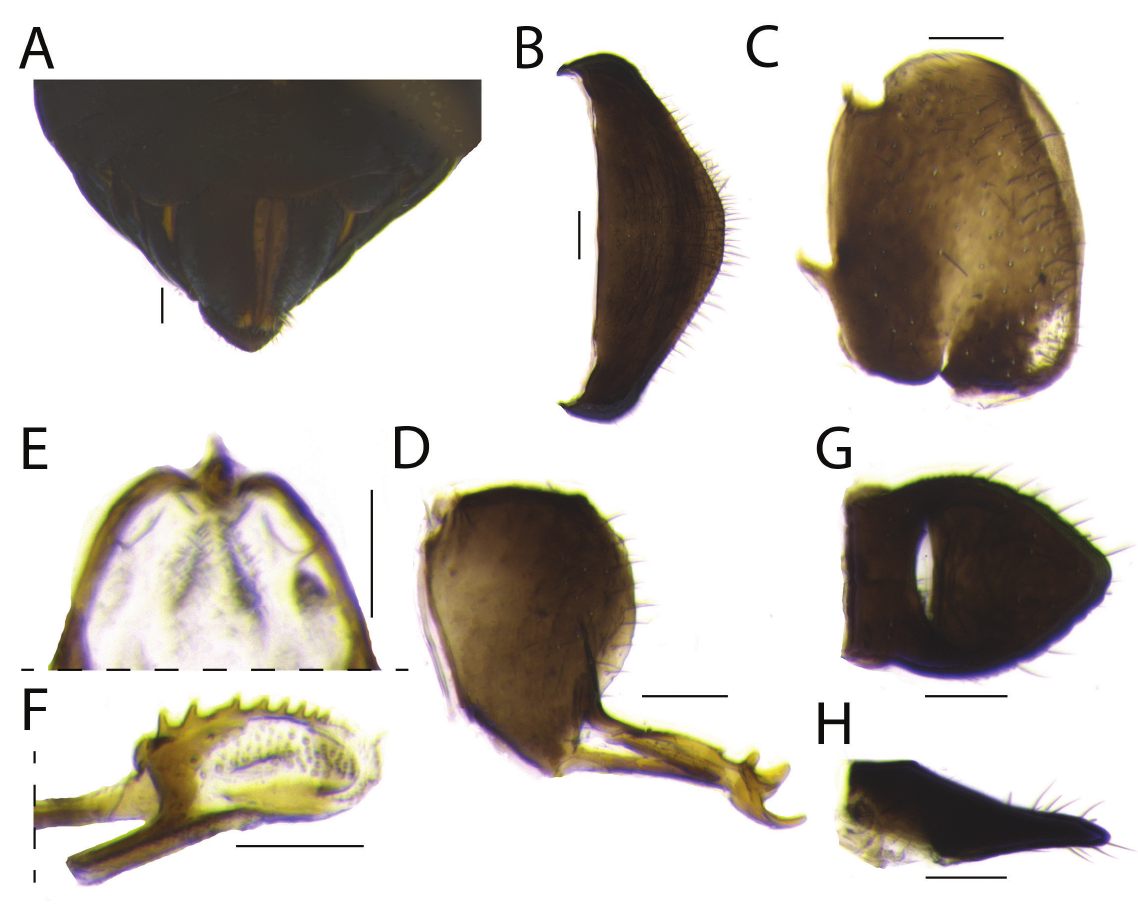
Fig. 8. Female terminalia of Bruchomorpha mormo Kirkaldy, 1907 (DZRJ). A . External female terminalia, ventral view. B . Sternite VII, ventral view. C . Gonoplac, lateral view. D . Anterior connective lamina of gonapophysis VIII, ventral view. E–F . Posterior connective lamina of gonapophysis IX. E . Connective part in dorsal view. F . Distal part in lateral view. G–H . Anal tube. G . Dorsal view. H . Lateral view. Scale bars = 0.1